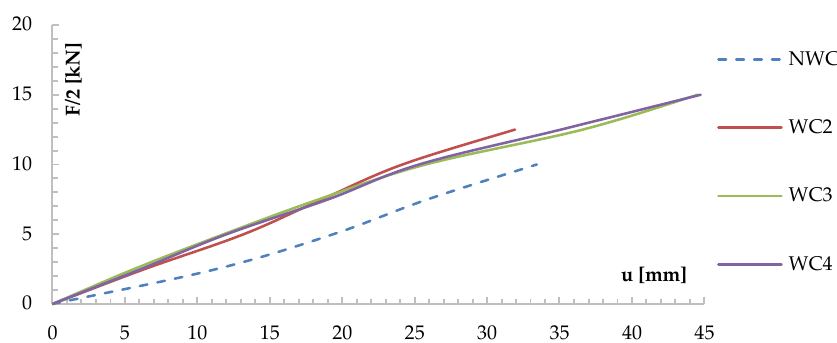
Figure 7. Graph of the relationship between u and F / 2 for the tested beams, measured at the middle of the span.